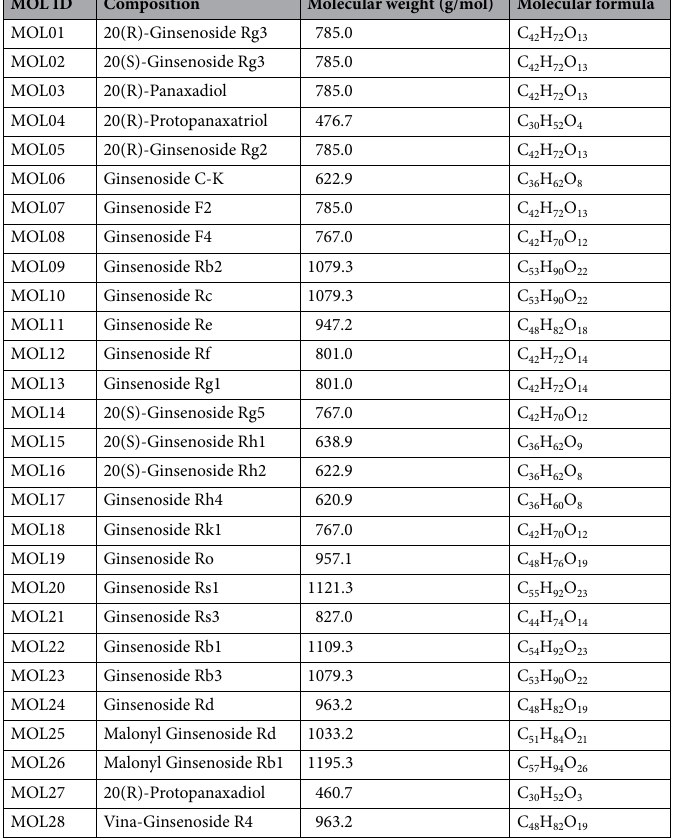
Table 1. The ginsenosides and their information.